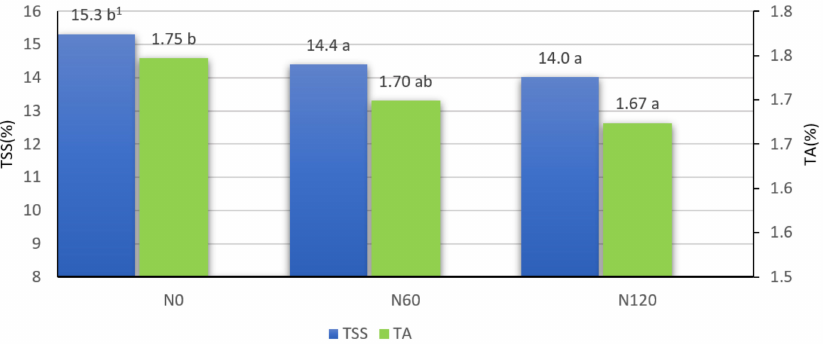
Figure 13. The effect of nitrogen fertilization on total soluble solids (TSS), titratable acidity (TA). Average for all orchards (OR 1, OR 2, OR 2) in years 2007–2013. 1 means that the same letters are not significantly different at α = 0.05 (Duncan’s test).